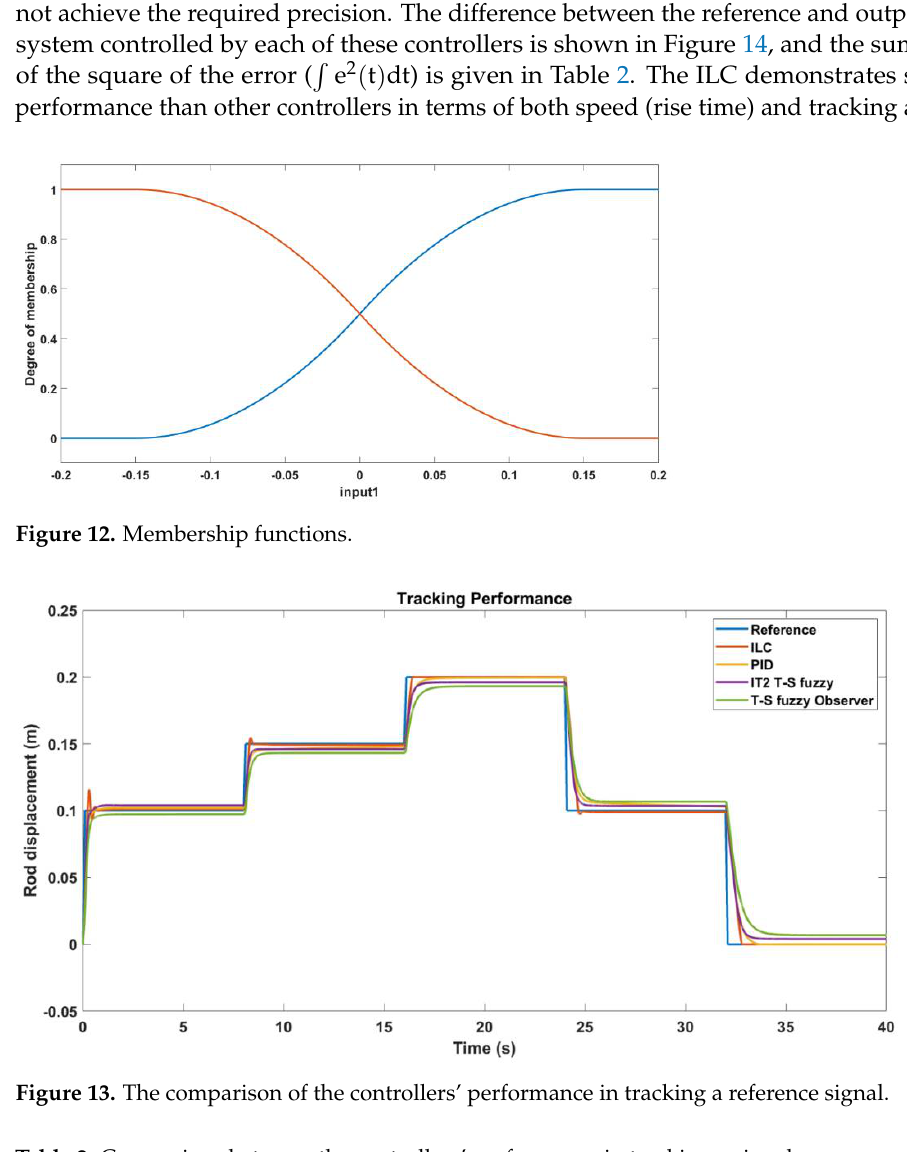
Table 2. Comparison between the controllers’ performance in tracking a signal.